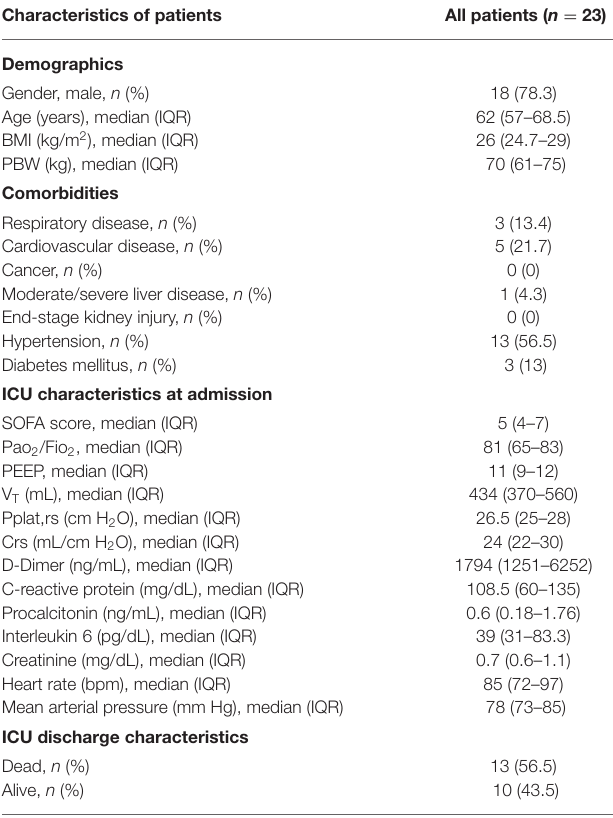
TABLE 1 | Characteristics of the patients included in the study. Characteristics of